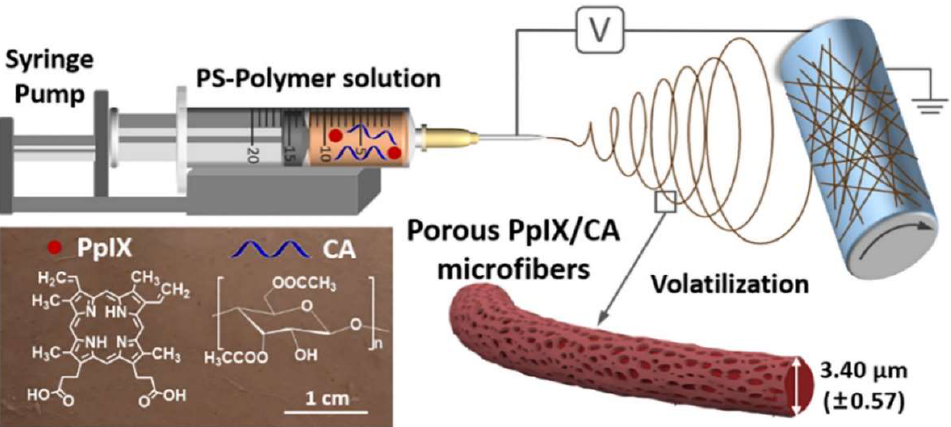
Figure 10. Scheme for the preparation of the porous PPIX -cellulose diacetate ( PPIX@CA ) membrane by electrospinning. Reprinted with permission from Ref. [141] . 2021, Elsevier.